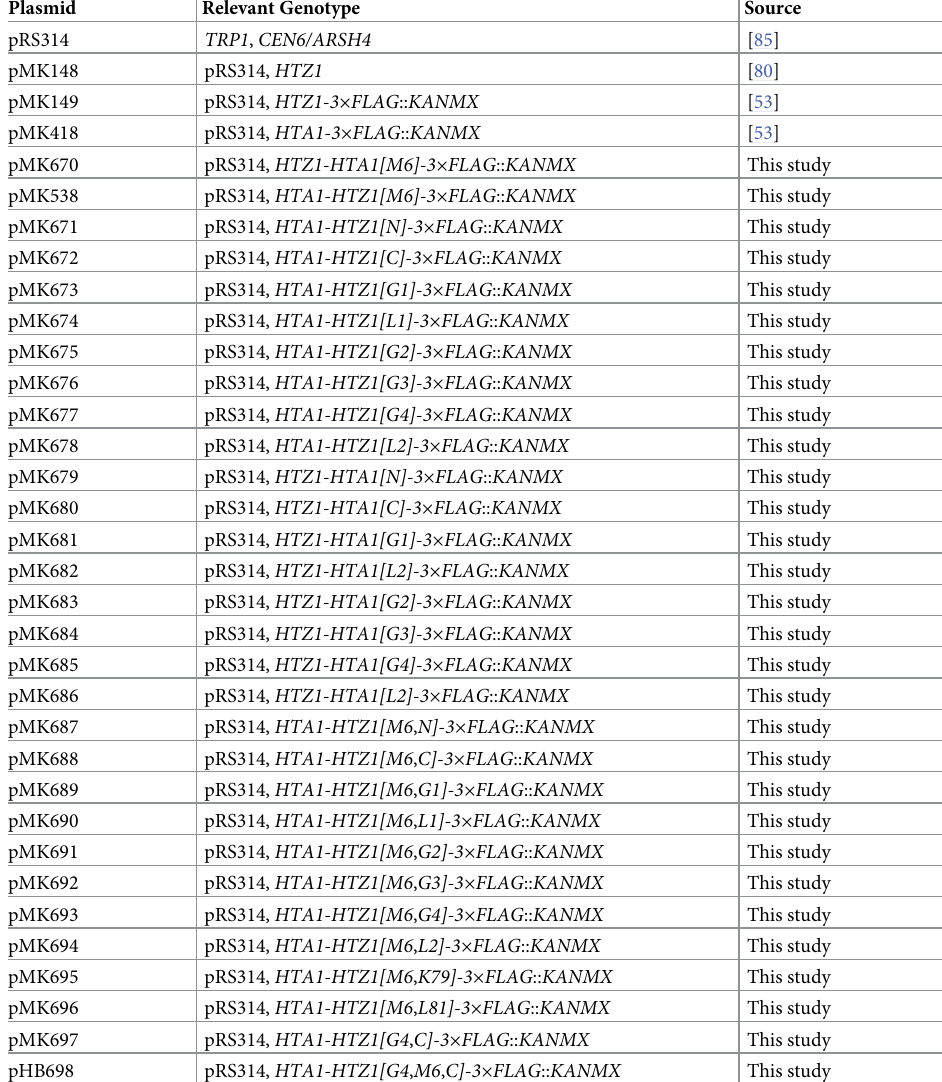
Table 2. Plasmids used in this study. Plasmid Relevant Genotype